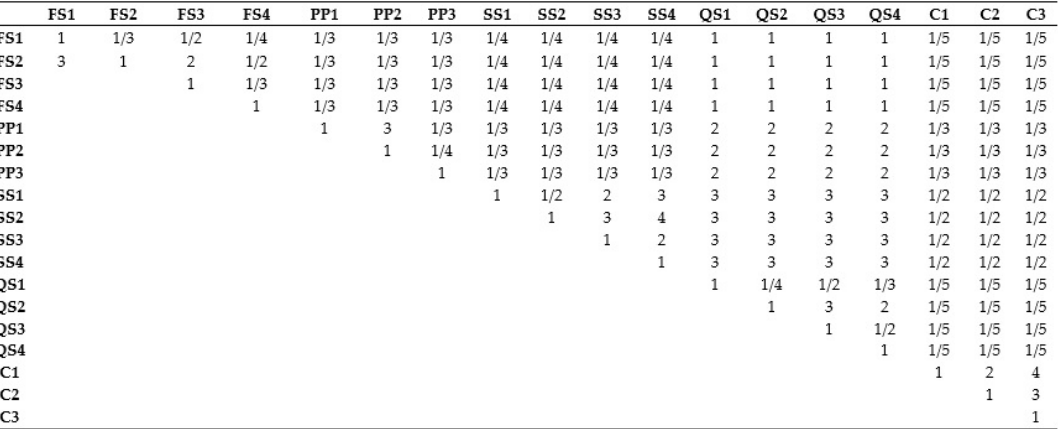
Figure 4. The results of pairwise comparison for the sub-criteria. Table 3. The priority results of the sub-criteria.